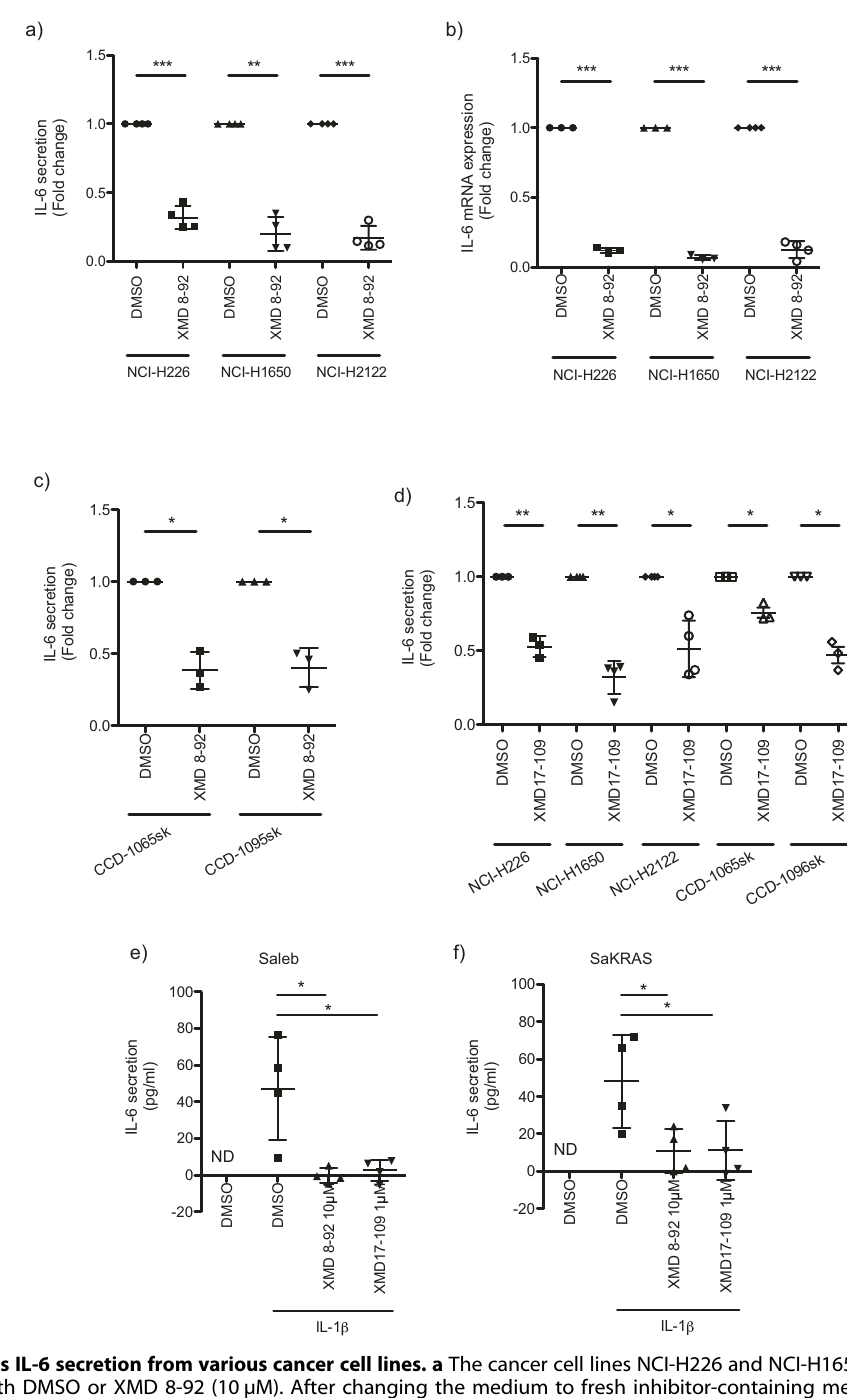
Fig. 5 ERK5 regulates IL-6 secretion from various cancer cell lines. a The cancer cell lines NCI-H226 and NCI-H1650 were treated for 4 h and NCI-H2122 for 2 h with DMSO or XMD 8-92 (10 µM). After changing the medium to fresh inhibitor-containing medium, supernatant of NCI- H226 and NCI-H1650 was harvested after 4 h, and in the case of NCI-H2122 after 5 h of incubation. IL-6 secretion was studied by ELISA (mean fold change ± SD; n = 4) and b , IL-6 mRNA levels were determined by real-time PCR (mean fold change ± SD; NCI-H226/NCI-H1650: n = 3; NCI- H2122: n = 4). c Same as in ( a ), but with CCD-1065sk and CCD-1095sk fi broblasts (mean fold change ± SD; n = 3). d NCI-H226, NCI-H1650, CCD- 1065sk, and CCD-1095sk fi broblasts were pre-treated with XMD 17-109 (NCI-H226, CCD-1065sk, and CCD-1095sk fi broblasts: 10 µM; NCI-H1650, NCI-H2122: 5 µM) for 4 h and NCI-H2122 for 2 h. After changing the medium to fresh inhibitor-containing medium, supernatant of NCI-H226, NCI-H1650, CCD-1065sk, and CCD-1095sk fi broblasts were harvested after 4 h, and in the case of NCI-H2122 after 5 h of incubation. IL-6 secretion was determined by ELISA (mean fold change ± SD; NCI-H226, CCD-1065sk and CCD-1095sk fi broblasts: n = 3; NCI-H1650, NCI- H2122: n = 4). e Saleb, and f , SaKRAS cells were pre-treated with DMSO, XMD 8-92 (10 µM) or XMD17-109 (1 µM) in presence or absence of IL- 1 β (10 ng/ml) for 1 h. The medium was replaced, and treatment was continued for 5 h. The supernatant was collected, and IL-6 secretion was determined by ELISA (mean ± SD; n =